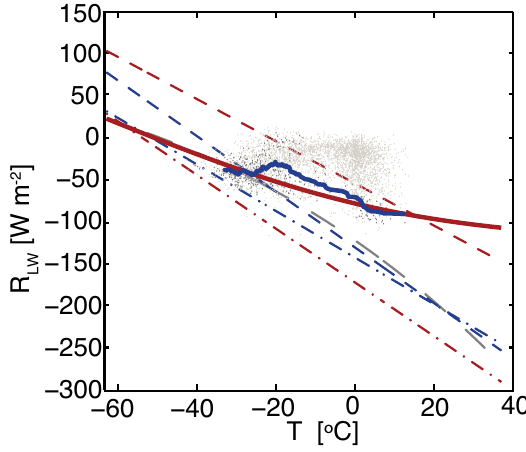
Fig. 2. Longwave radiative energy budget R LW versus surface tem- perature T , with negative values signifying a heat loss of the surface to the atmosphere. The light grey dots represent daily averages for the 14yr record of ARM’s longwave radiative budget data for Bar- row, AK (ARM, 2010) for all sky (cloudy and clear) conditions. The black dots mark the subset of data points for clear sky conditions, assuming that the sky is free of clouds if the skyward pointing IR thermometer reads values below 220K. These scattered clear sky data are filtered with a 50 data point wide moving average (solid blue line). The longwave budget (solid red line) from Eq. (7) is fitted to these filtered clear sky data with a higher weight to the regions of higher data density, and yields a = − 1 . 05Wm − 2 K − 1 and b = b 0 = 301Wm − 2 . Longwave radiative energy budgets used in other conceptual models are plotted for comparison: parameter- ization by Notz (2009) (dashed grey line; increased by 100Wm − 2 to fit the figure); Thorndike (1992) (dash-dotted lines) differenti- ates between a summer (red) and winter (blue) parameterization; and Eisenman and Wettlaufer (2009) (dashed lines) use monthly varying parameterizations that expand between a maximum (Au- gust, red) and minimum curve (March, blue). All parameterizations are monotonously decreasing with T , consistent with the clear sky 50 point running